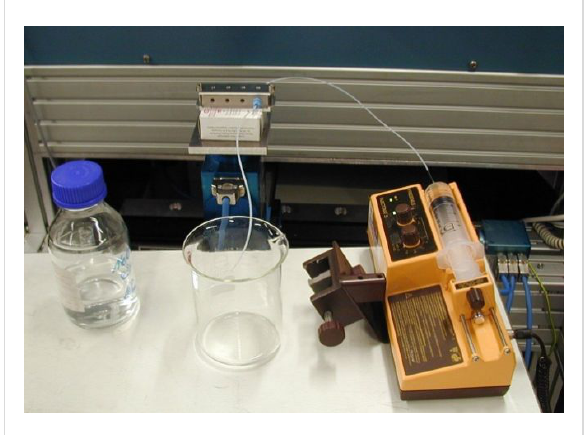
Figure 5: Test setup with continuously operating, miniaturized photoreactor.